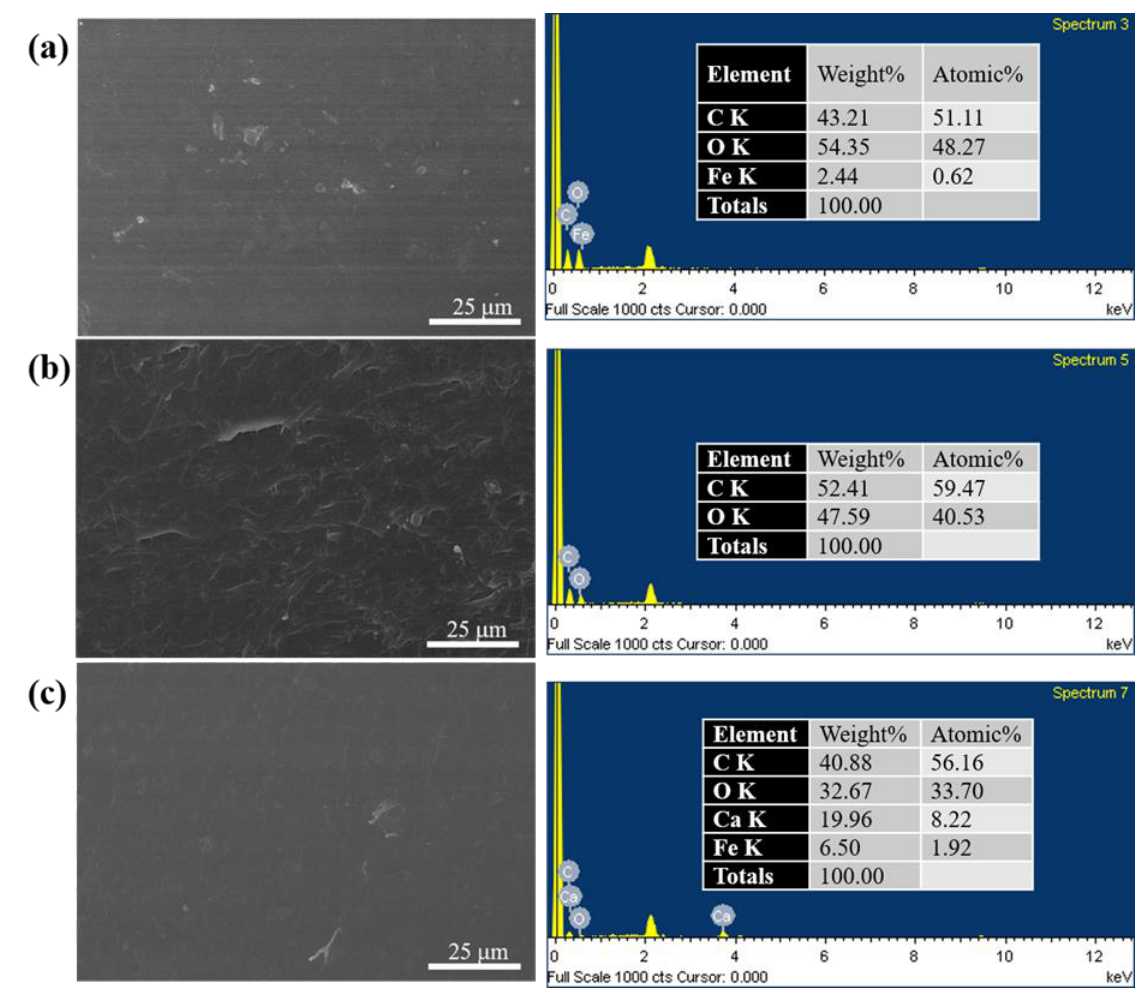
Figure 1. SEM images and EDS of ( a ) S1, ( b ) S2, and ( c ) S3.